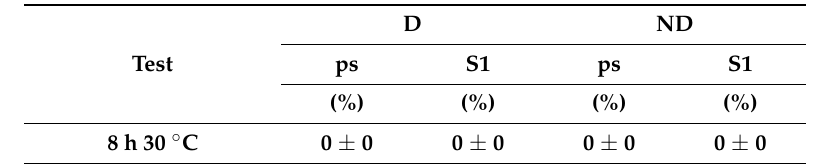
Table 1. Germination tests (averages ± se). Germination recorded as pericarp splitting (ps, first visible stage of germination) and as seedling growth stage S1 (S1, rootlet or coleoptile ≥ 1 mm). Averages obtained for the seeds used in the RNA-Seq experiment (3 replicates of 15 seeds, 45 seeds total)